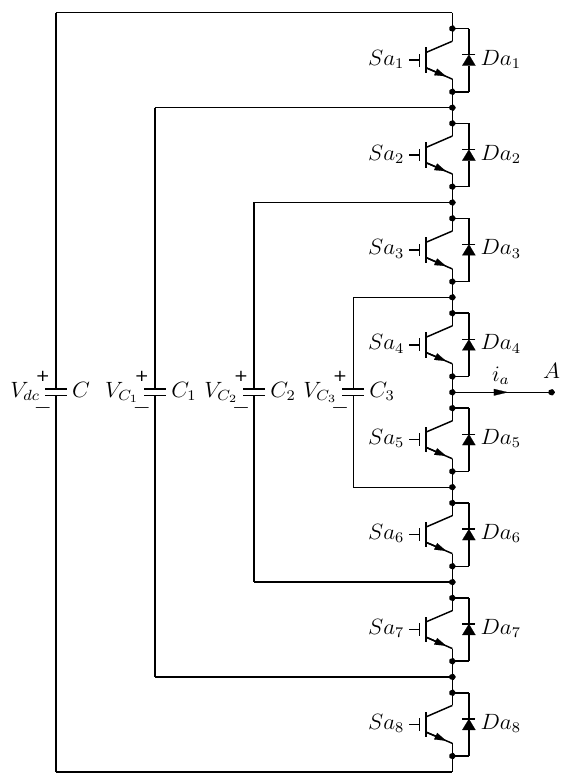
Figure 3. Phase leg of a five-level flying-capacitor converter.